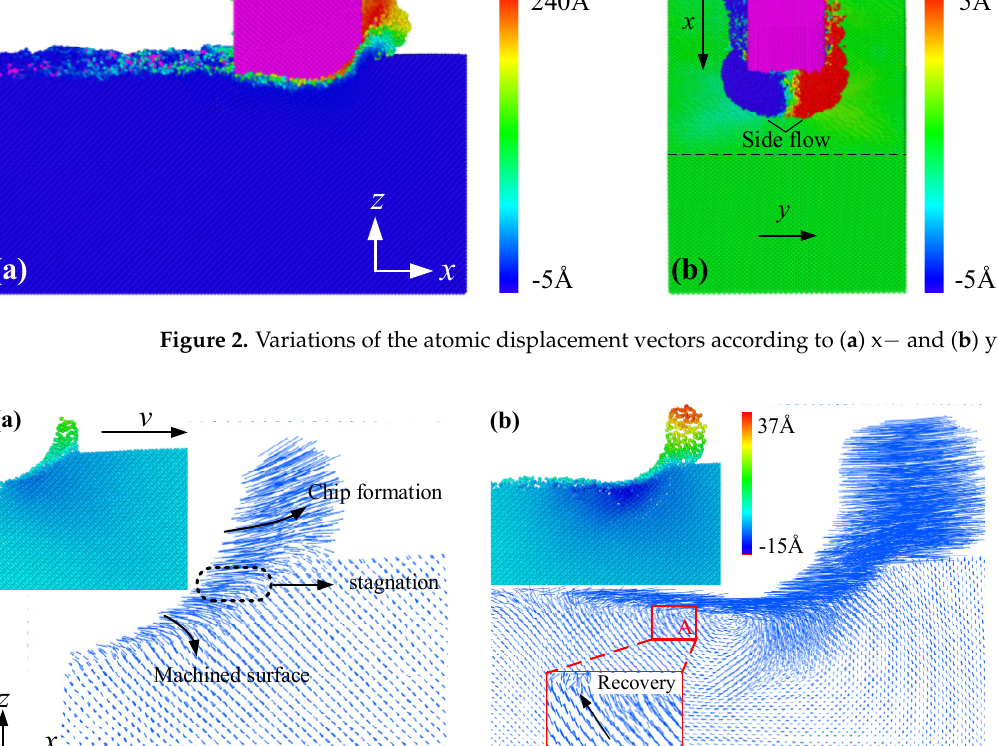
Figure 3. The displacement vectors of the workpiece atoms during nanometric cutting at a distance of ( a ) 4 nm and ( b ) 16 nm.